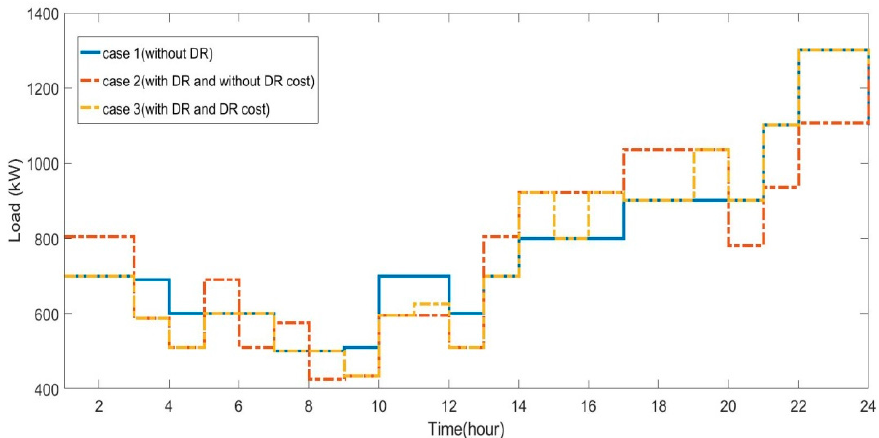
Figure 7. Load with and without demand response (DR) in scenario 10.